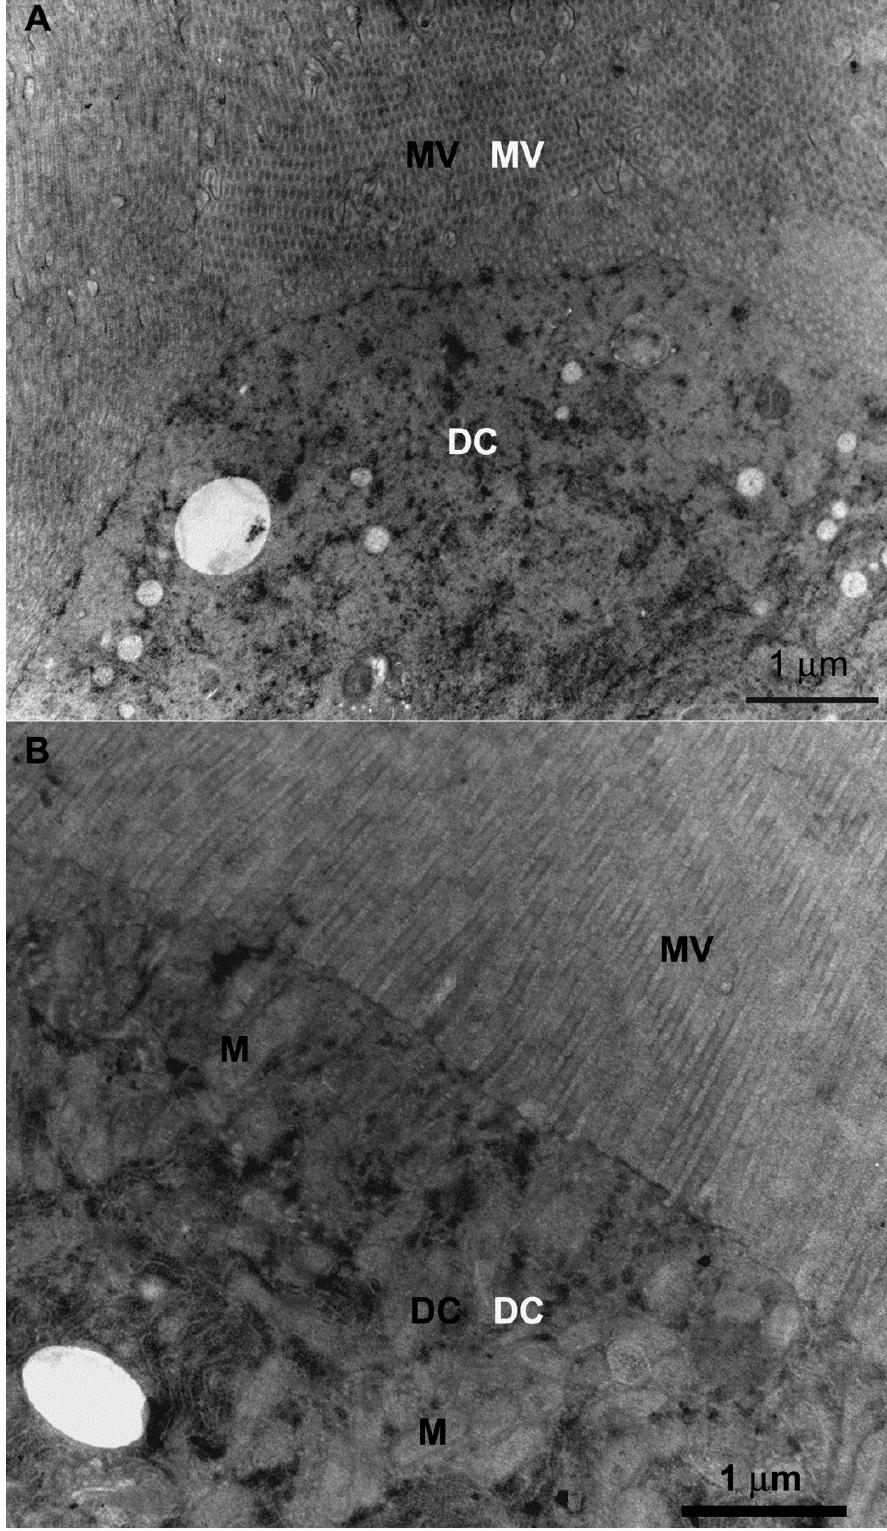
Figure 3. Transmission electron micrographs of digestive cell in the anterior midgut region of Friesella schrottkyi worker. ( A ) Apical region of the digestive cell (DC) showing many long microvilli (MV). ( B ) Apical region of the digestive cell (DC) showing closely packed microvilli (MV) and cytoplasm with mitochondria (M).